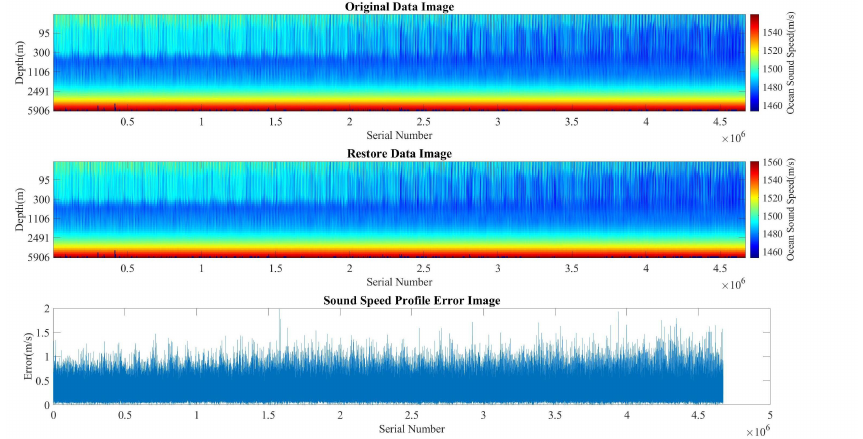
Figure 8. Performance of dictionary learning compression under spatial discrete structure ( k = 100, T = 3).